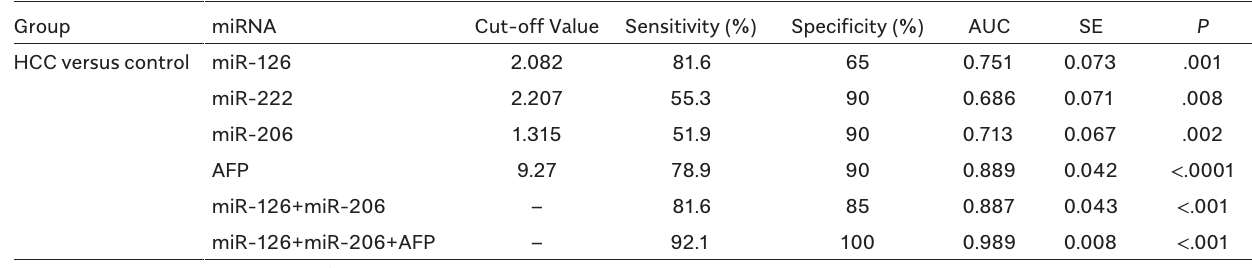
Table 2. Discriminative Ability of Individual and Combined miRNAs (2 − ΔΔCt ) and AFP Between HCC and Control Group miRNA